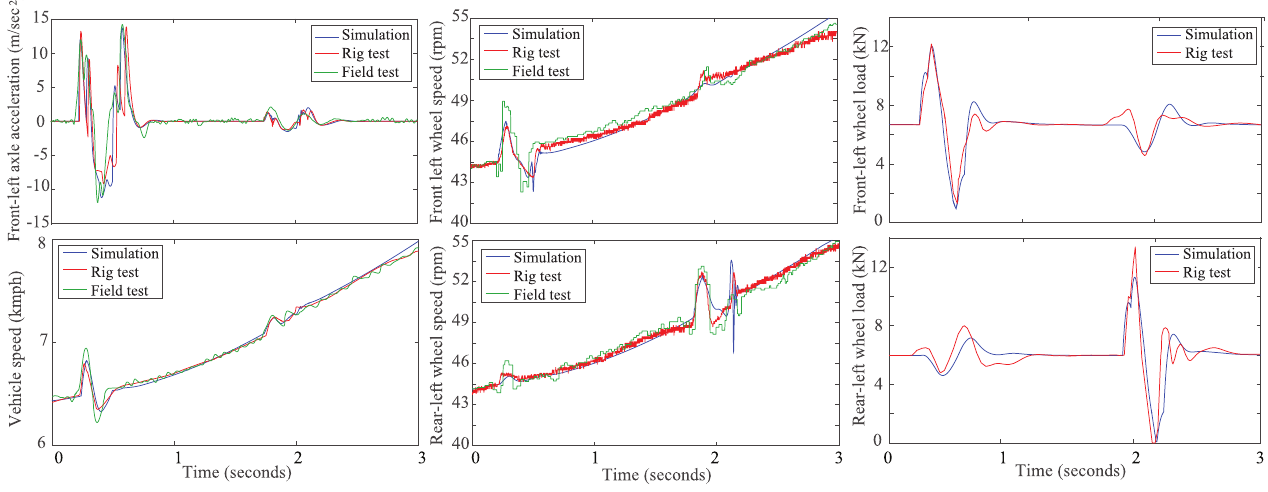
Fig. 18. Simulation versus test